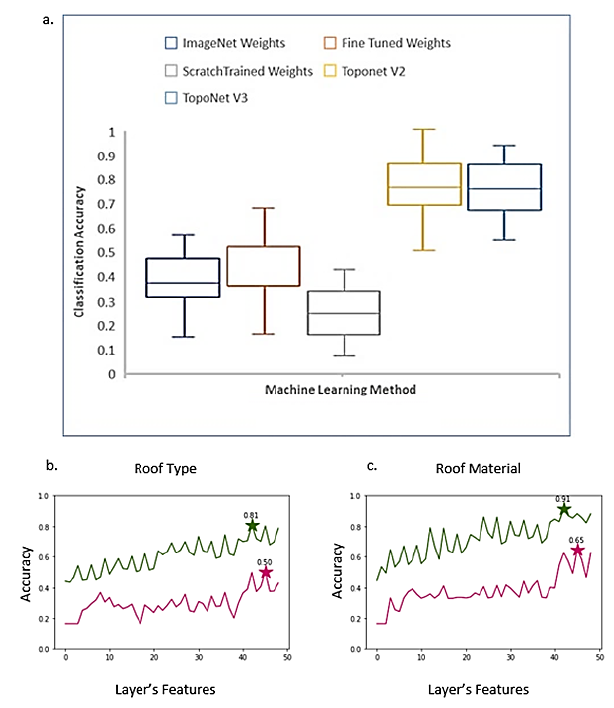
Figure 2. Comparison of classification accuracy from features extracted by the deep neural network, TopoNet. a. overall classification accuracy of recent versions of TopoNet (orange and blue) when compared against other deep learning networks (ImageNet, and two early experiments at training deep networks with aerial imagery). b. accuracy for inference of roof types, and c. accuracy for inference of roof material, comparing both ImageNet and TopoNet methods. Legend (b & c): Pink line: ImageNet features, Green line: TopoNet features